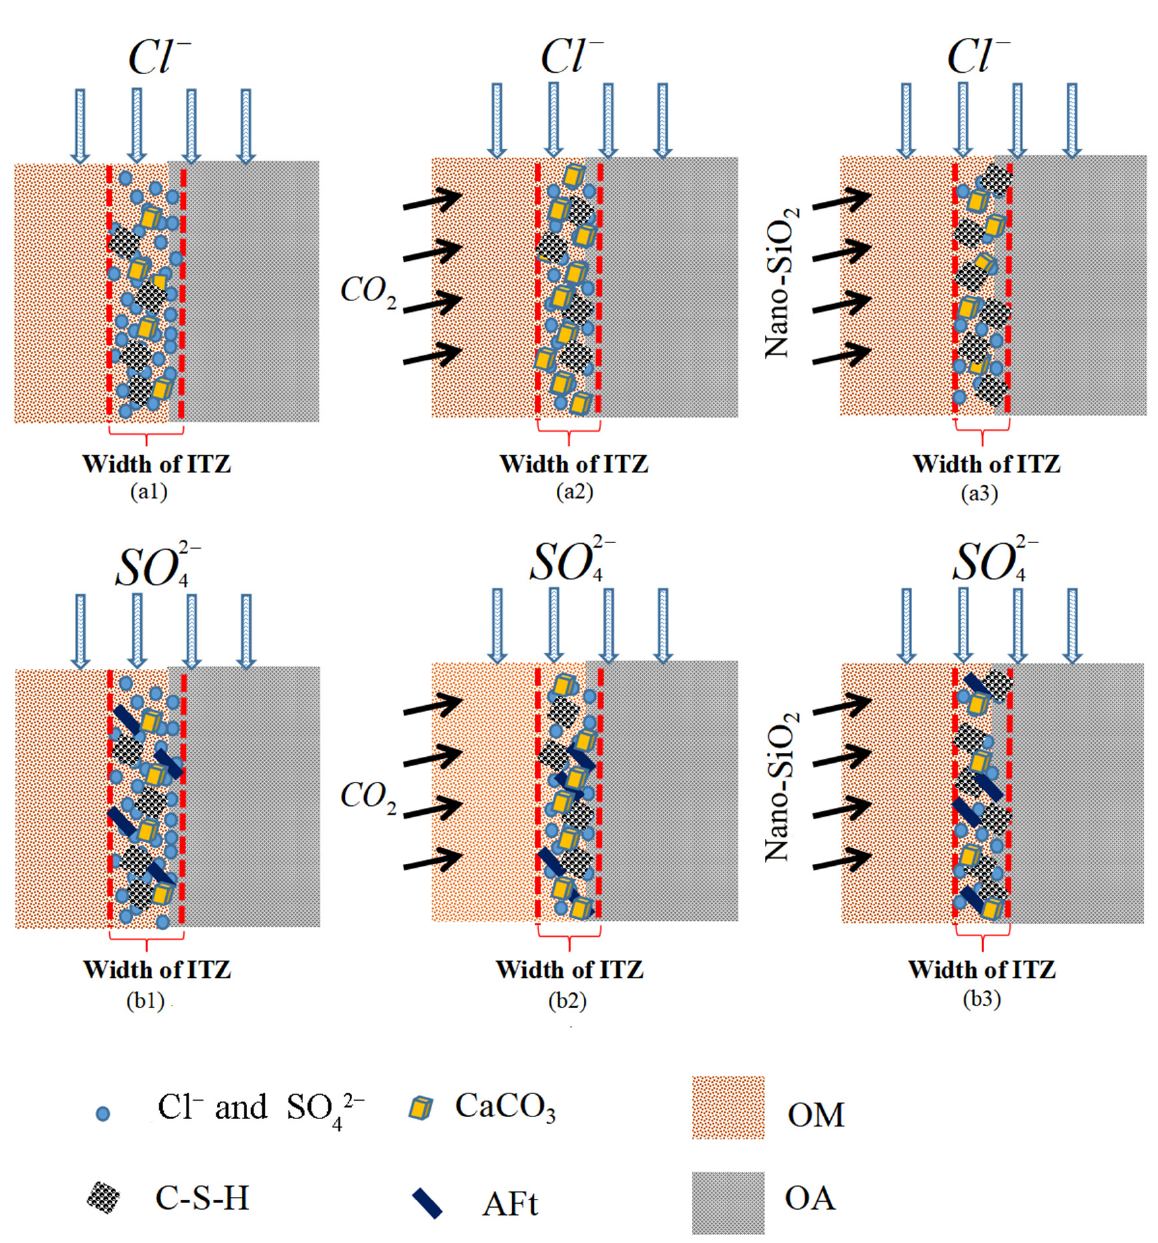
Figure 14. Schematic diagram of influence of aggregate modification on OA-OM-ITZ: ( a1 , a2 , a3 ) modified RC under Cl − erosion, ( b1 , b2 , b3 ) modified RC under SO 42 − erosion.